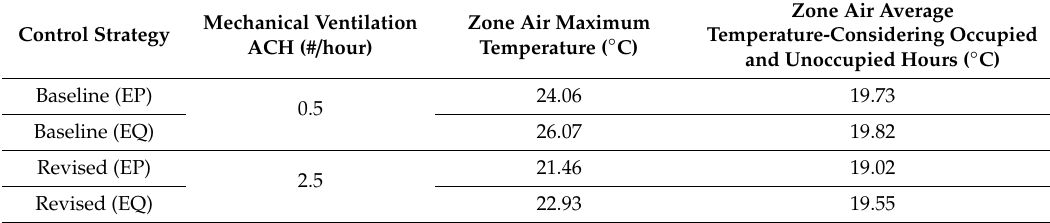
Table 8. Elimination of